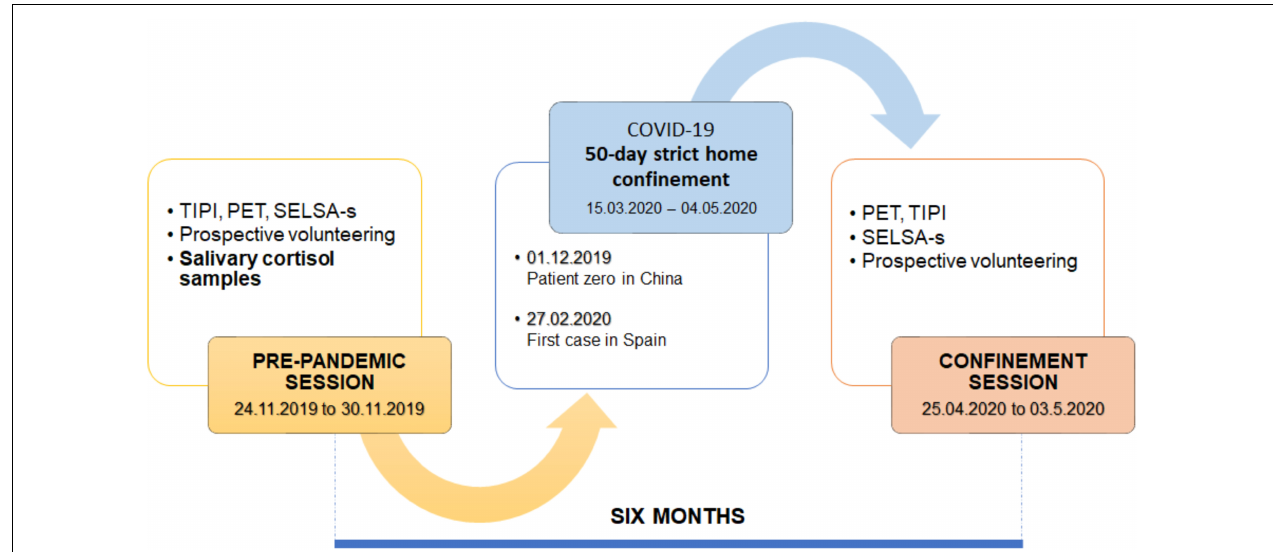
FIGURE 2 | Study timeline. SELSA-S, Social and Emotional Loneliness Scale-Short; PET, Pictorial Empathy Test; TIPI, Ten-Item Personality